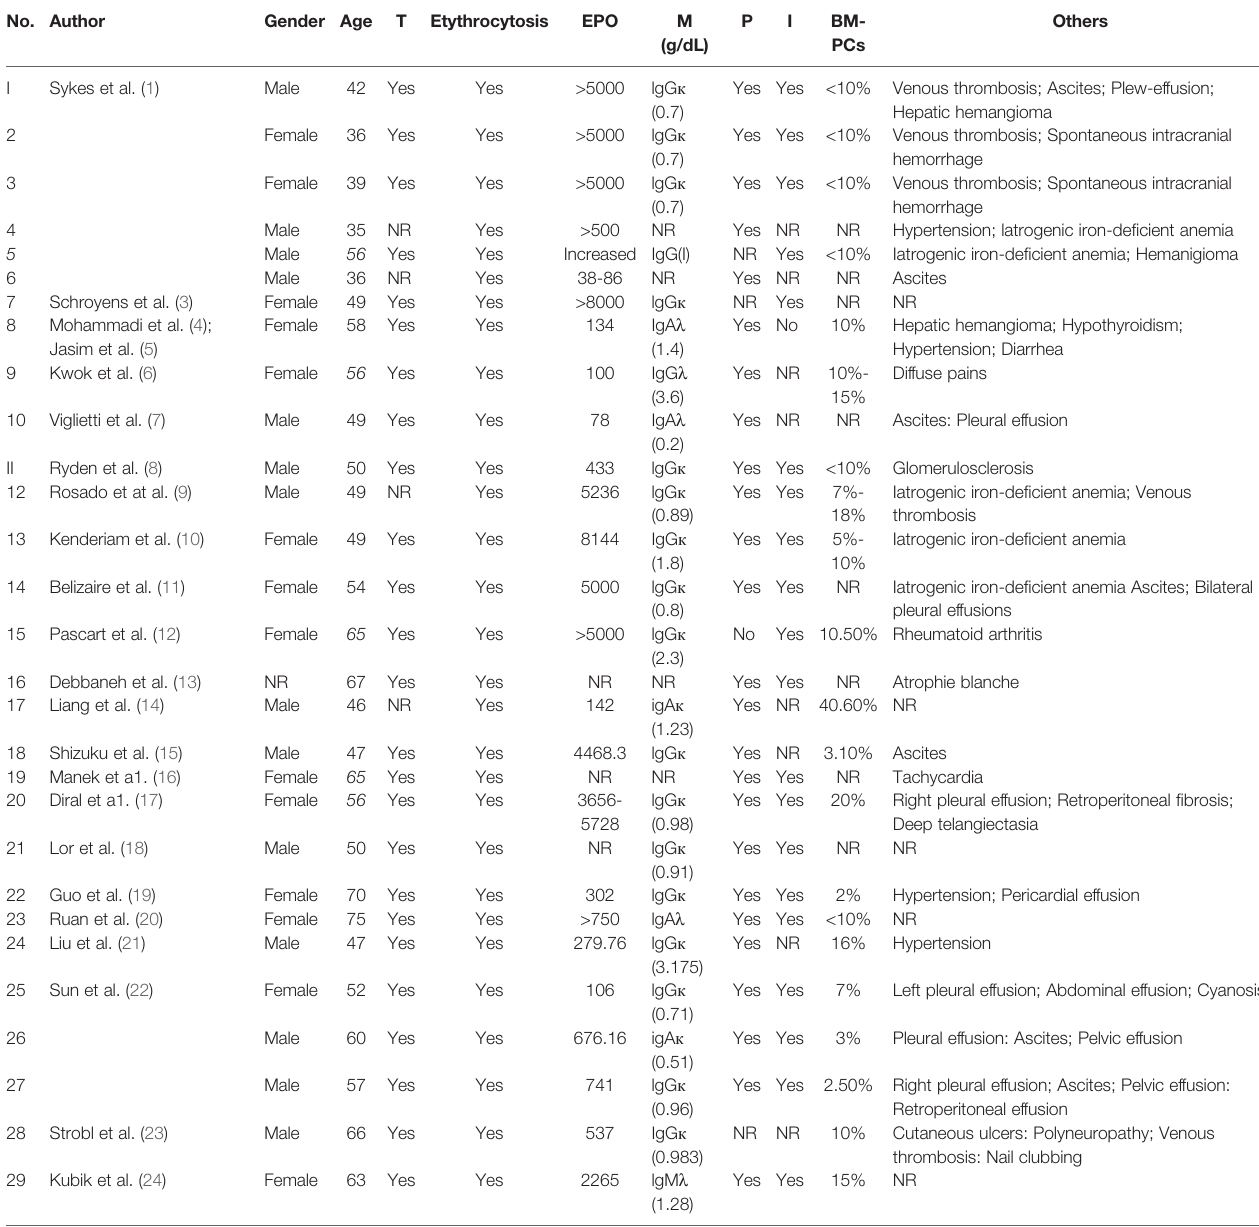
TABLE 1 | Characteristics of patients reported with the TEMPI